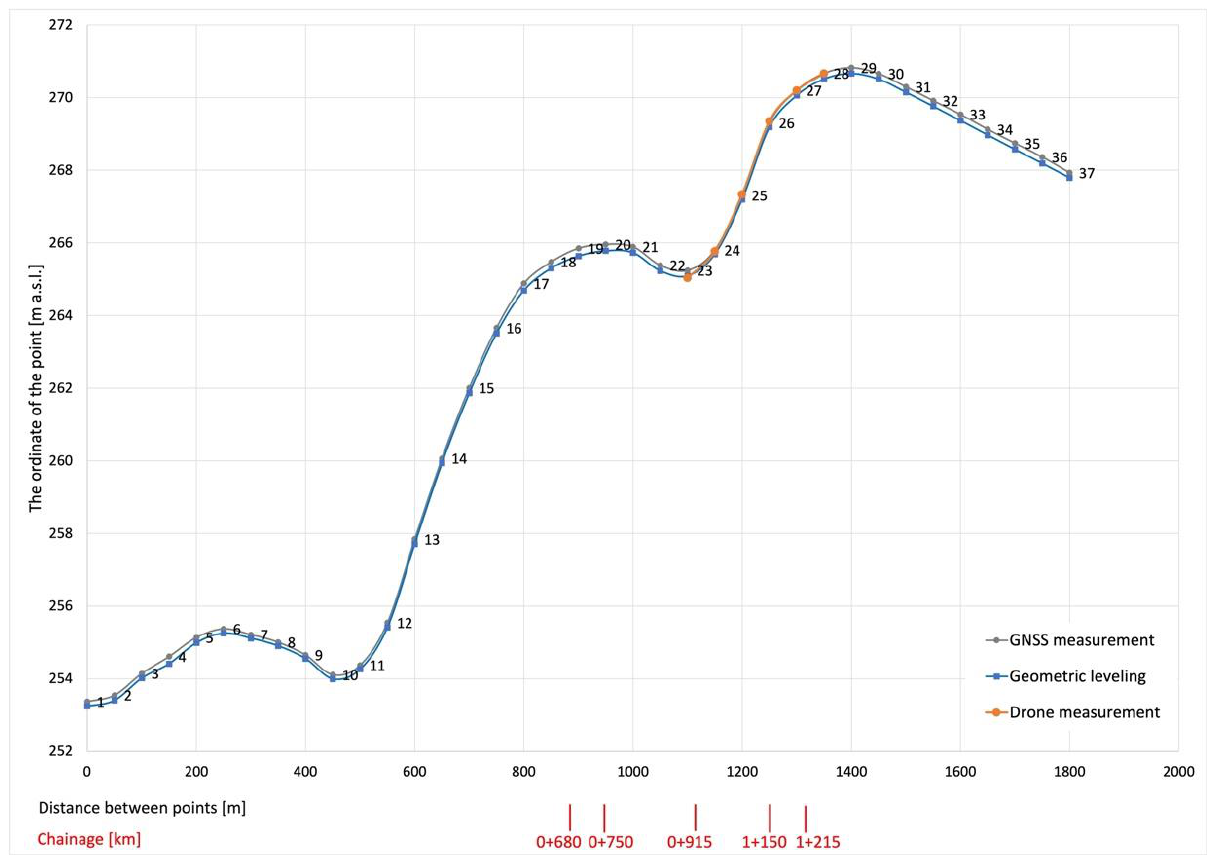
Figure 13. Graph of point ordinates for the observed measurement line with the division into the measurement methods used.